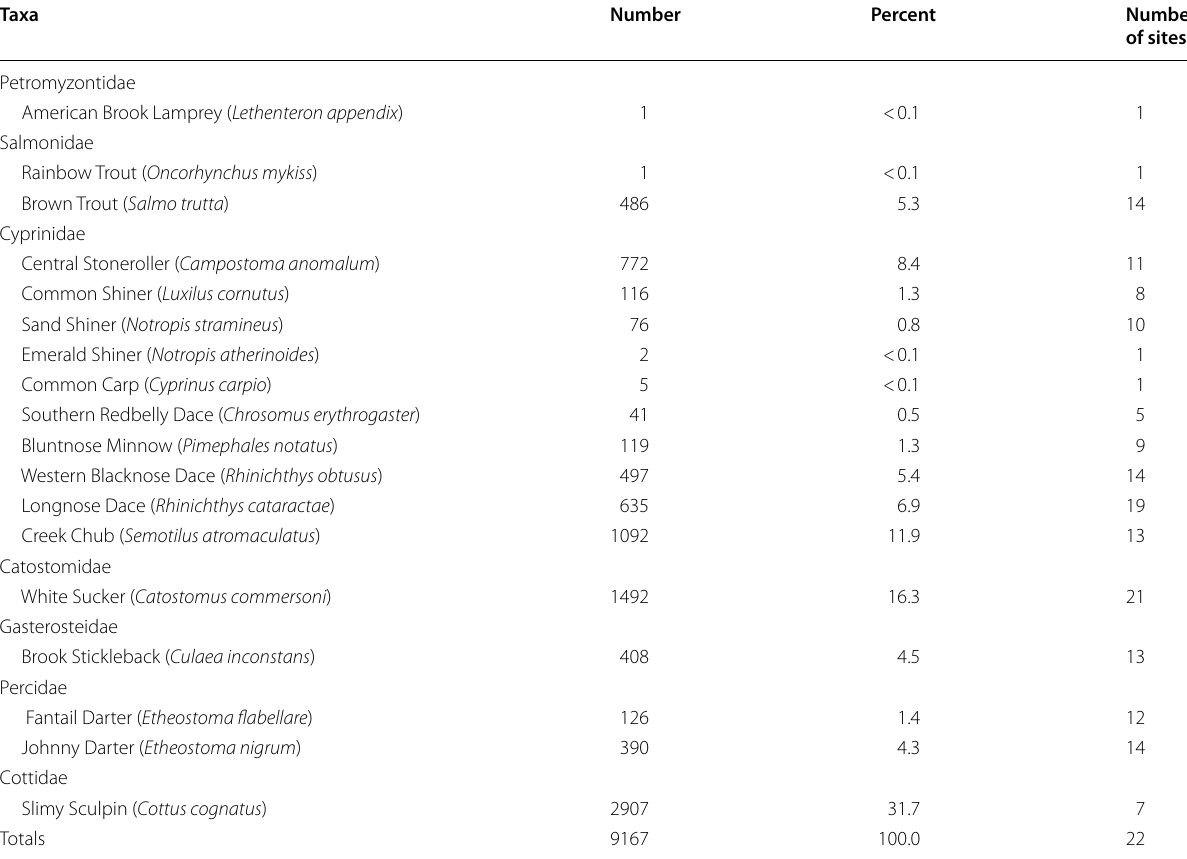
Table 1 Fish species collected from 22 sites on the South Fork Whitewater River, Minnesota, USA Taxa